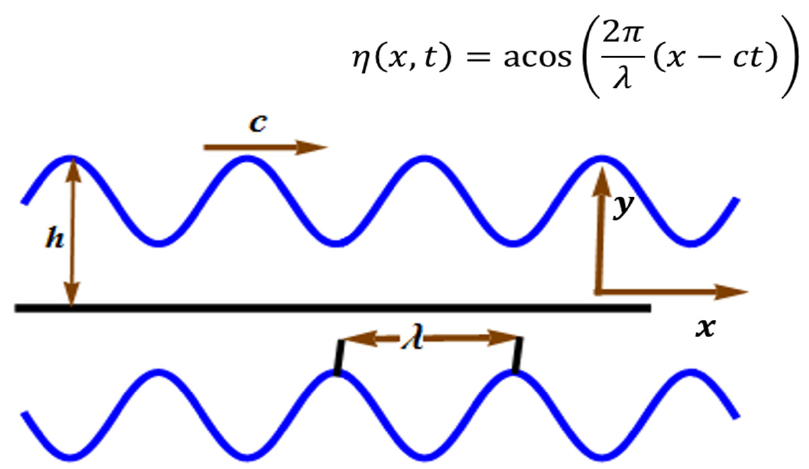
Figure 1. Geometry of the problem.